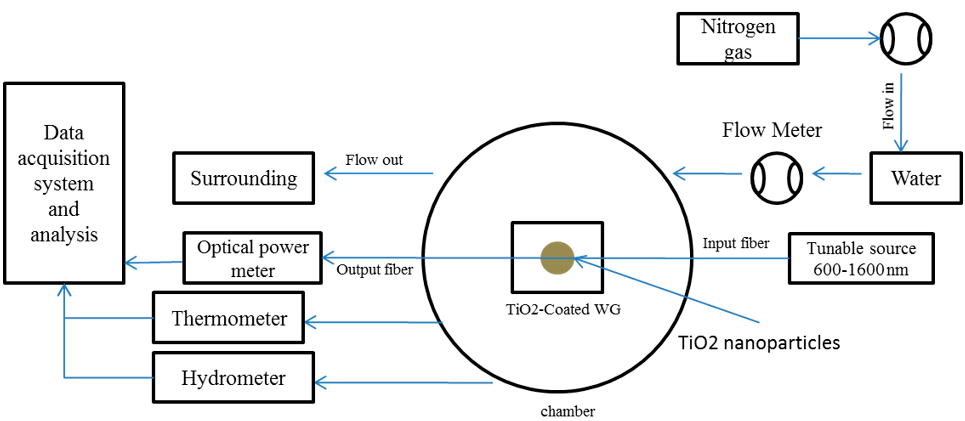
Figure 3. Experimental setup to control humidity and temperature in the chamber and measure the power loss variation at different RHs.